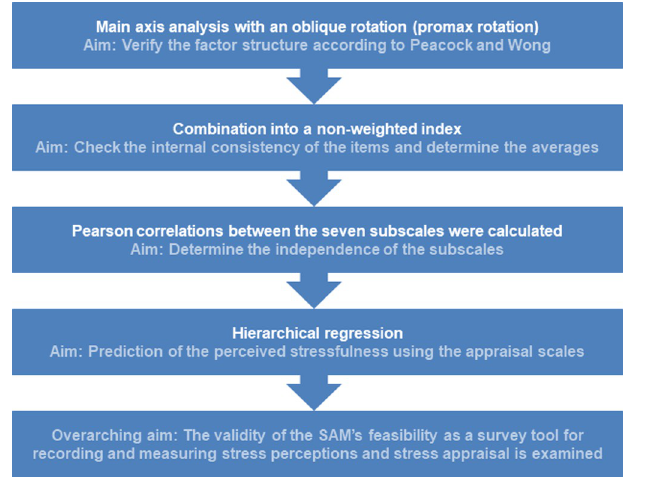
Fig 1. Data analysis. Notes: SAM, Stress Appraisal Measure [25], German version by [26].